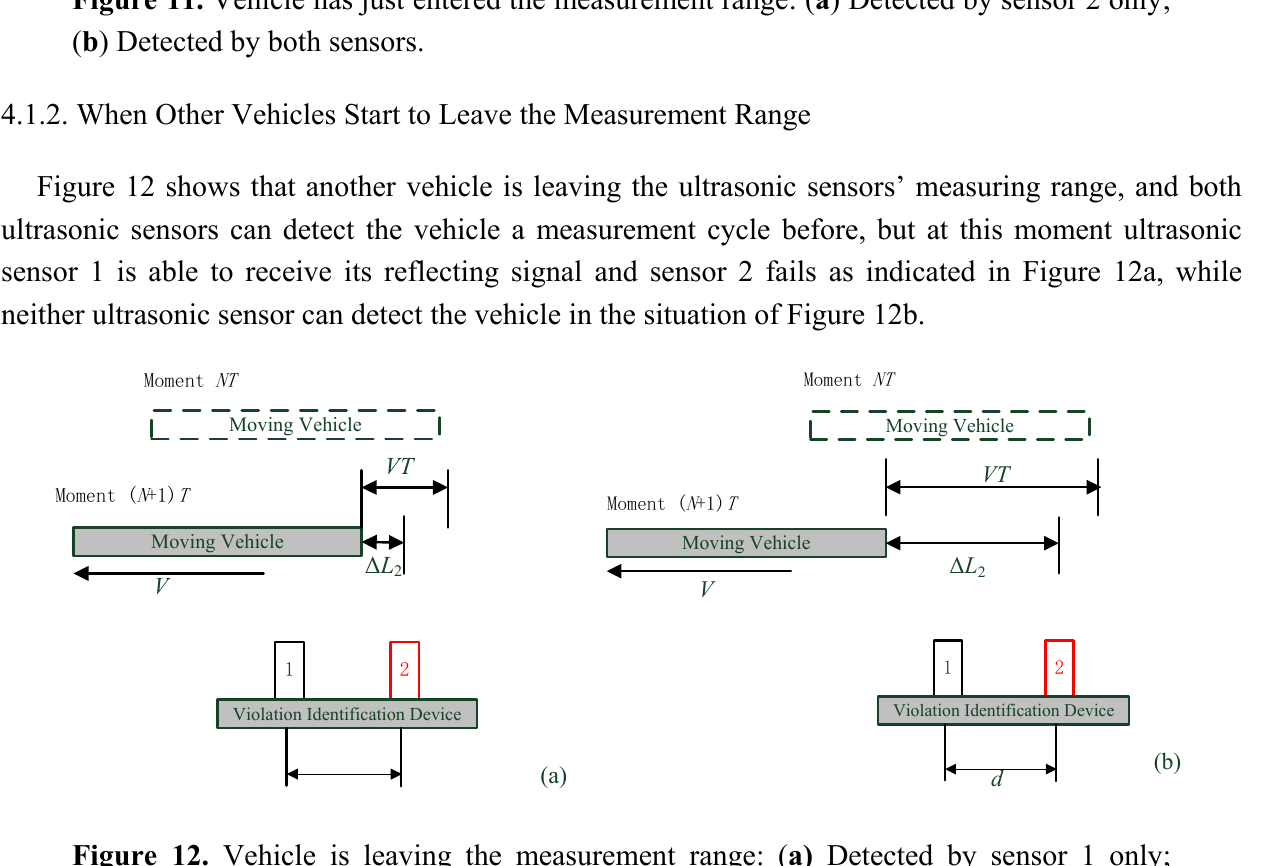
Figure 12. Vehicle is leaving the measurement range: ( a) Detected by sensor 1 only; (b) Detected by no